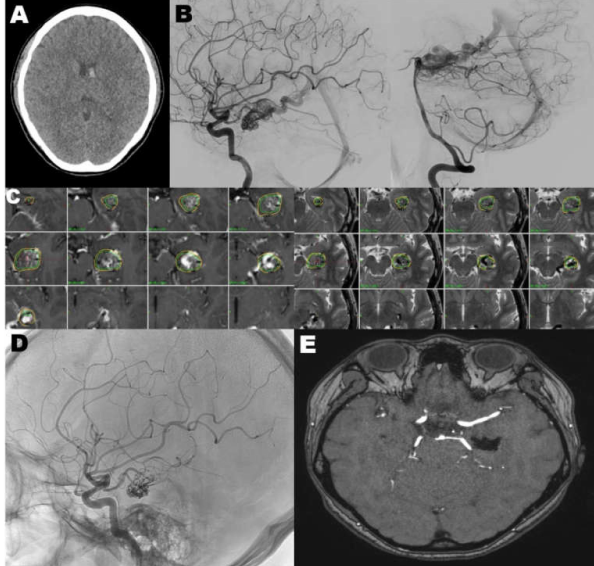
Figure 2. ( A ) The non-contrast enhanced computed tomography showed an acute intraventricular hemorrhage. (B) The digital subtraction angiography confirmed a Spetzler-Martin grade III AVM in the left temporal lobe with feeders from the left anterior choroidal artery and left posterior cerebral artery with venous ectasia, draining to the left basal vein of Rosenthal. ( C ) Gamma knife radiosurgery (3.30 cm 3 , 18 Gy to 50% of the isodense line). ( D ) The final angiogram after Onxy embolization showed near complete occlusion of the AVM nidus with multiple intranidal aneurysms. ( E ) The last follow up magnetic resonance imaging (24 months after GKRS) revealed neither residual nidus nor flow